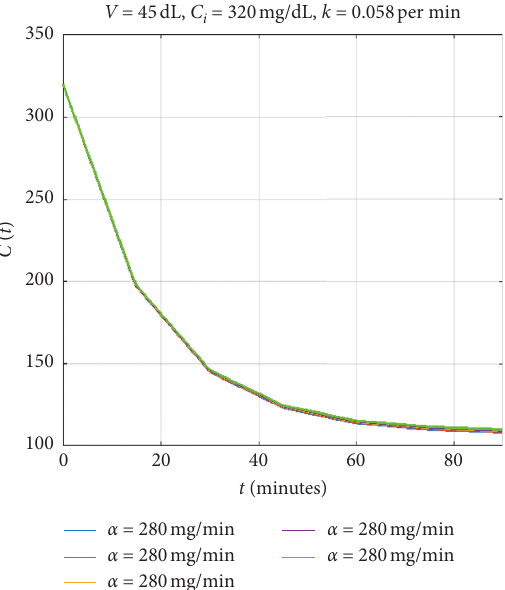
Figure 3: Blood glucose concentration C ( t ) for different values of the rate of infusion α and